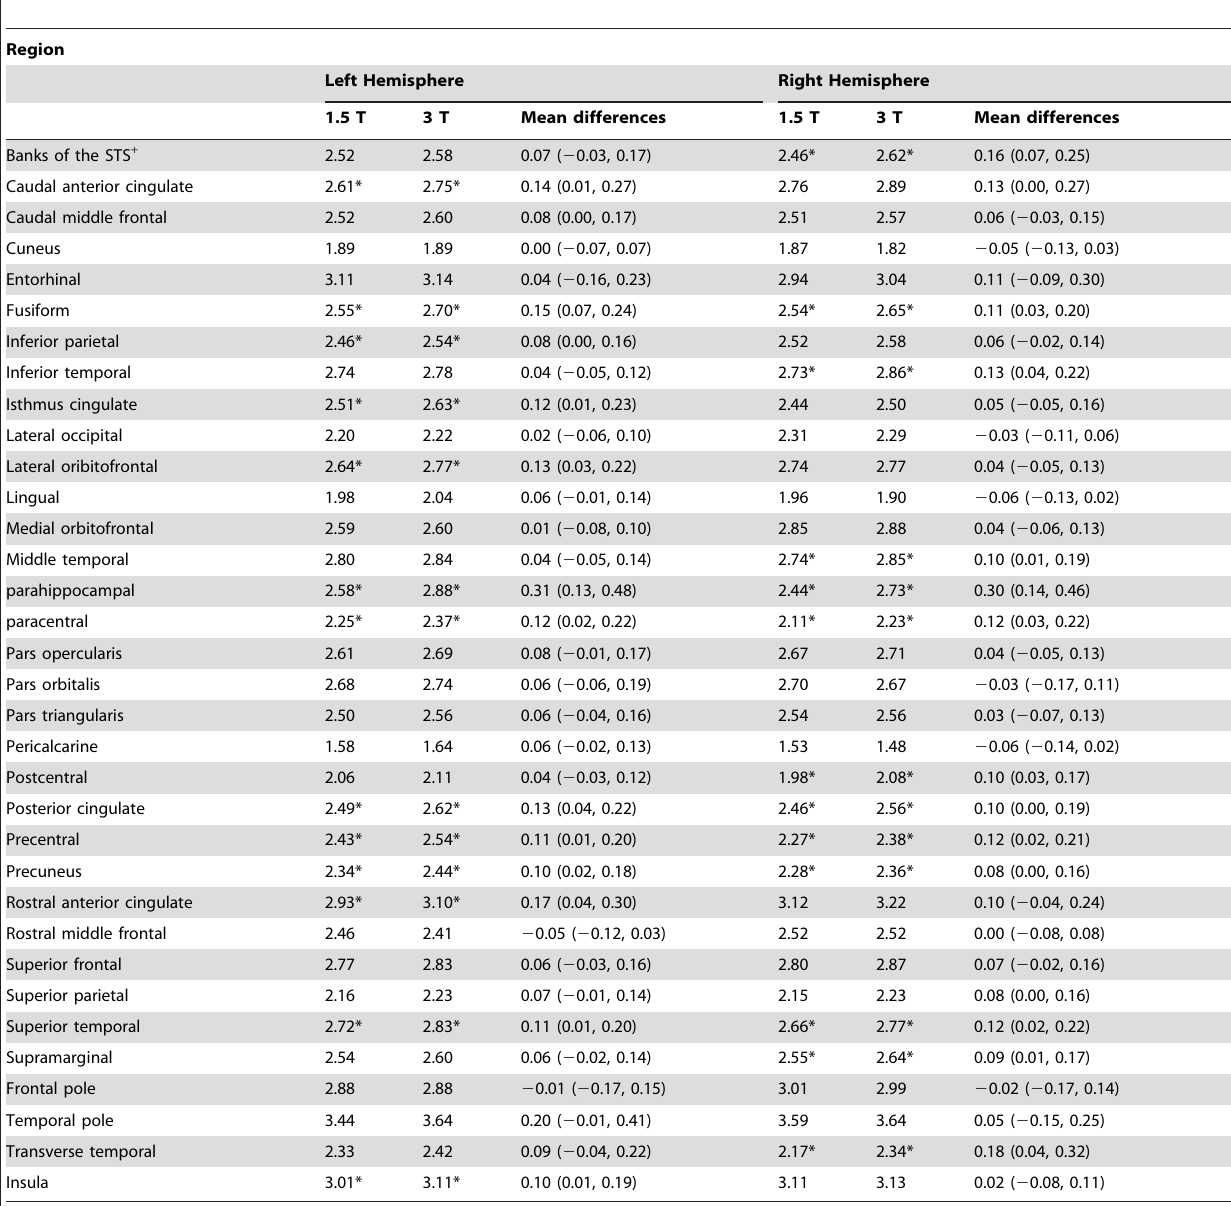
Table 5. Adjusted means and mean differences (95% confidence interval) of regional cortical thickness between 1.5 T and 3 T for females in the age group 20–40 after controlling for confounding